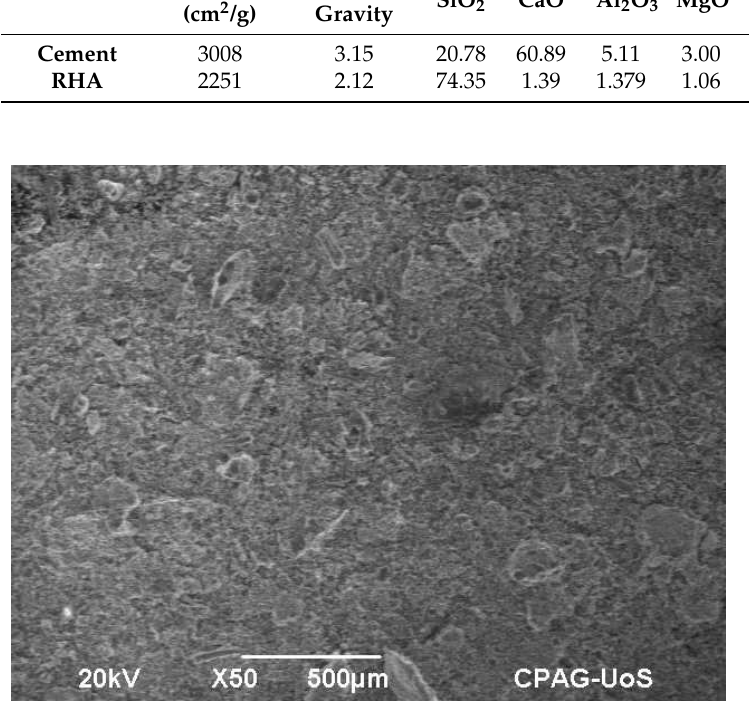
Figure 1. Scanning Electron Microscope (SEM) image at × 50 maginification (20 kV; 500 µm; 800 °C—2 h) of RHA particles.